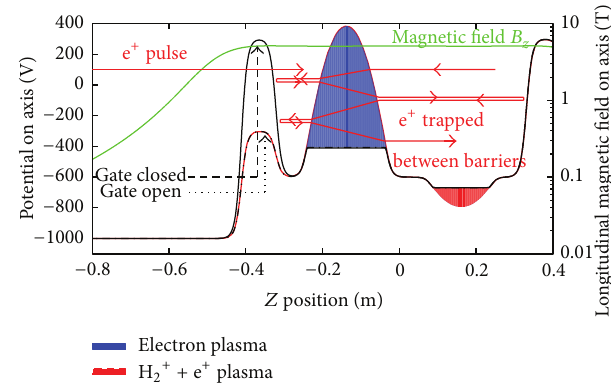
Figure 1: The positron trapping mechanism (from [30]). The horizontal axis is the position along the trap axis. The left vertical axis is the voltage seen by particles. The magnetic field strength is shown by the green curve, with the scale on the right vertical axis. In blue, the electron potential well filled with electrons is drawn, reducing the apparent voltage shown by black curve with the value on the left vertical axis. The positron potential is shown well in red. When a positron bunch arrives, the entrance electrode voltage is low (dashed dotted line). It is then increased and positrons go back and forth (it is depicted by red arrows) between this gate and the downstream part of the trap. They pass many times through the electron plasma and are eventually slowed down and fall into their well. The presence of residual H 2+ helps the final catching of positrons.Inordertoreachthedesirednumberoftrappedpositrons, the positron well has to be enlarged and deepened during the accumulation process from around 200 V to around 1kV. Positrons may also be trapped in the potential well formed between the entrance electrode and the electron well, but its depth remains constant and the induced loss is